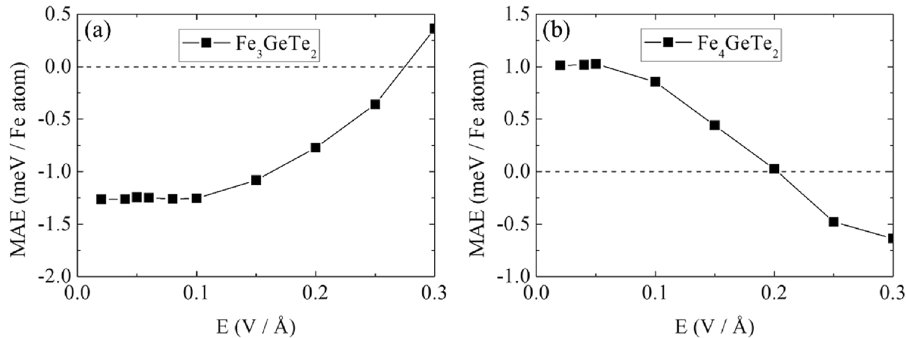
Figure 3. The MAE of ( a ) Fe 3 GeTe 2 and ( b ) Fe 4 GeTe 2 defined as E(001)–E(100). The positive (negative) values denote the preferred spin direction along in-plane (out-of-plane)